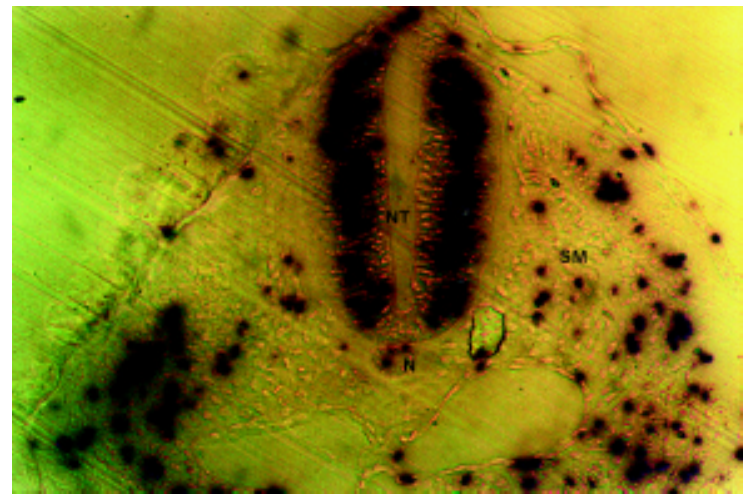
Figure 1 - Transverse section of a chicken embryo (56-h incubation) showing proliferating cells in the neural tube (NT), notochord (N) and somite (SM).